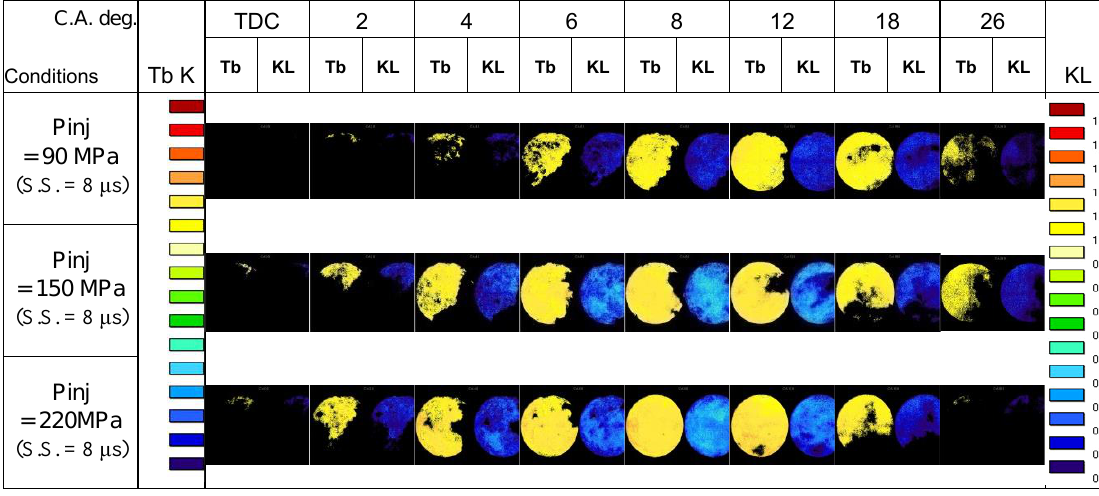
Fig. 17. Distribution images of flame temperature Tb and KL factor by changing Pinj at EGR rate 50%